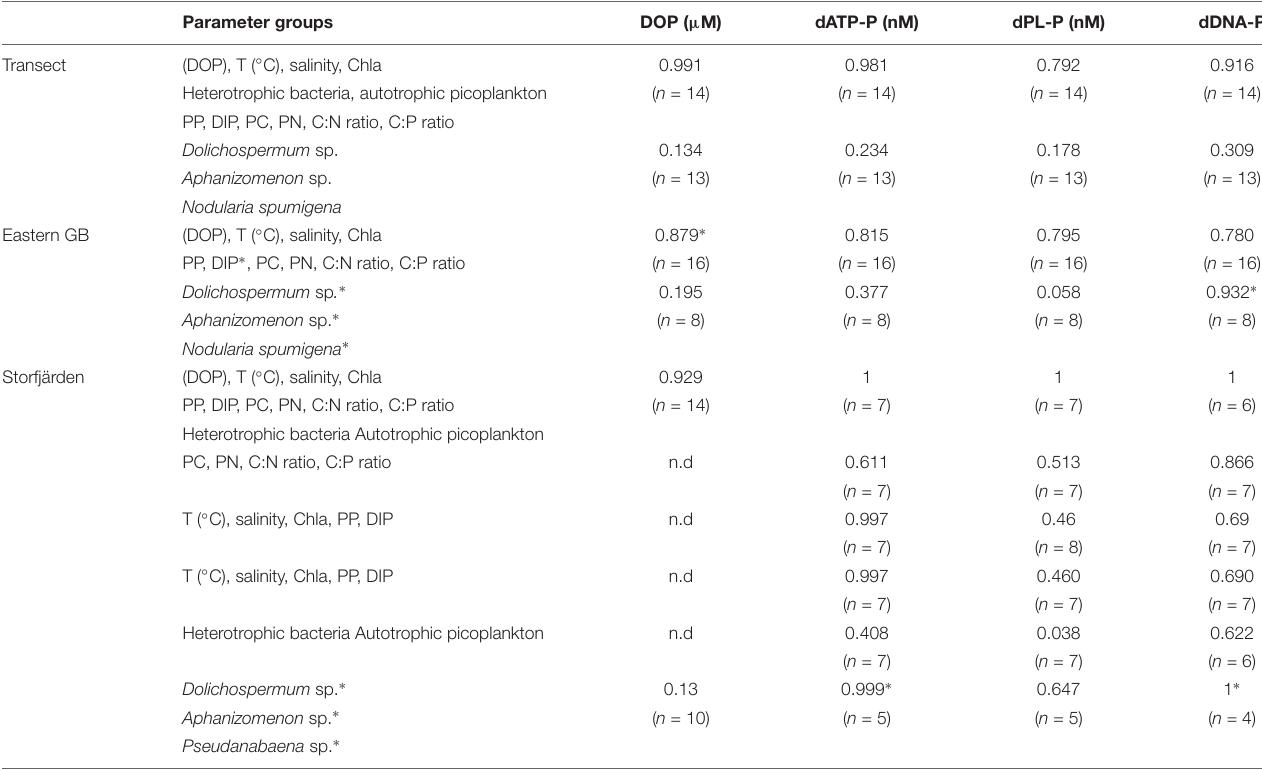
TABLE 5 | Coefficients of determination (CoD) to describe the impact of parameter groups on concentrations of DOP, dATP-P, dPL-P, and dDNA-P. Parameter groups DOP ( µ M) dATP-P (nM)